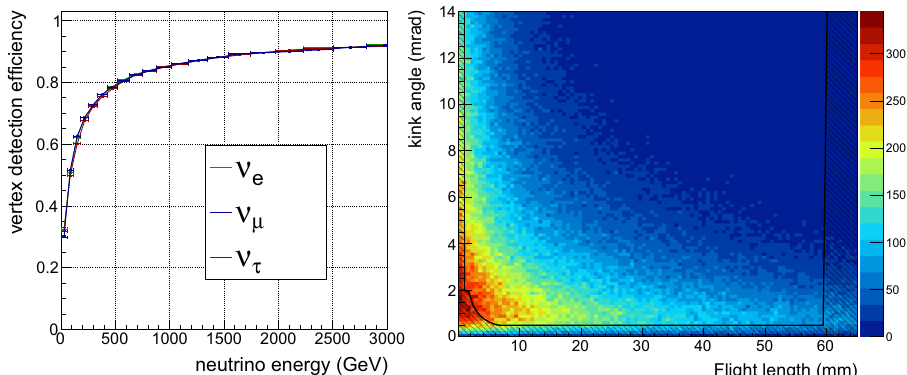
actions in FASER ν that produce tau leptons that decay through 1-prong decays. The black hatched region is excluded by the cuts described in the text; requiring the event to be in the unhatched region leads to a 75% τ detection efficiency